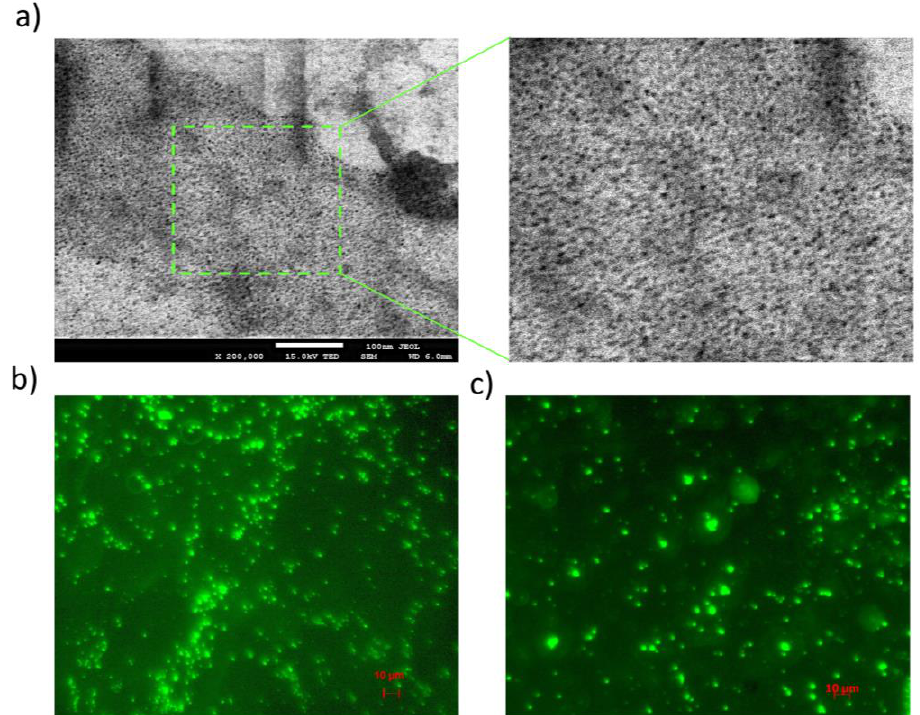
Figure 7. The visualization of the dendrimer structures of ( a ) the original G4PAMAM molecule using SEM; ( b ) the G4.0 PAMAM-DOX complex (1:6 at pH 9.5); and ( c ) the G4.0 PAMAM-DOX complex (1:12 at pH 9.5) from a fluorescence microscope.